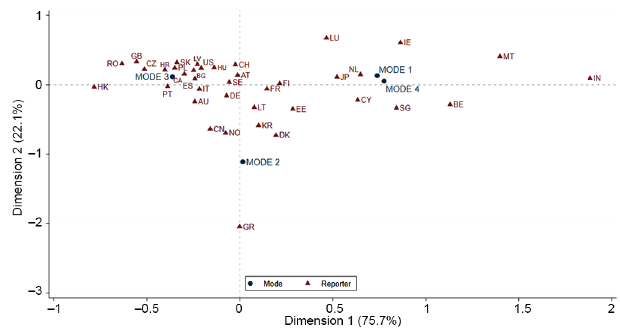
Figure 3. Service imports by mode and by country, 2017 (source: WTO mode of supply dataset, authors’ elaborations